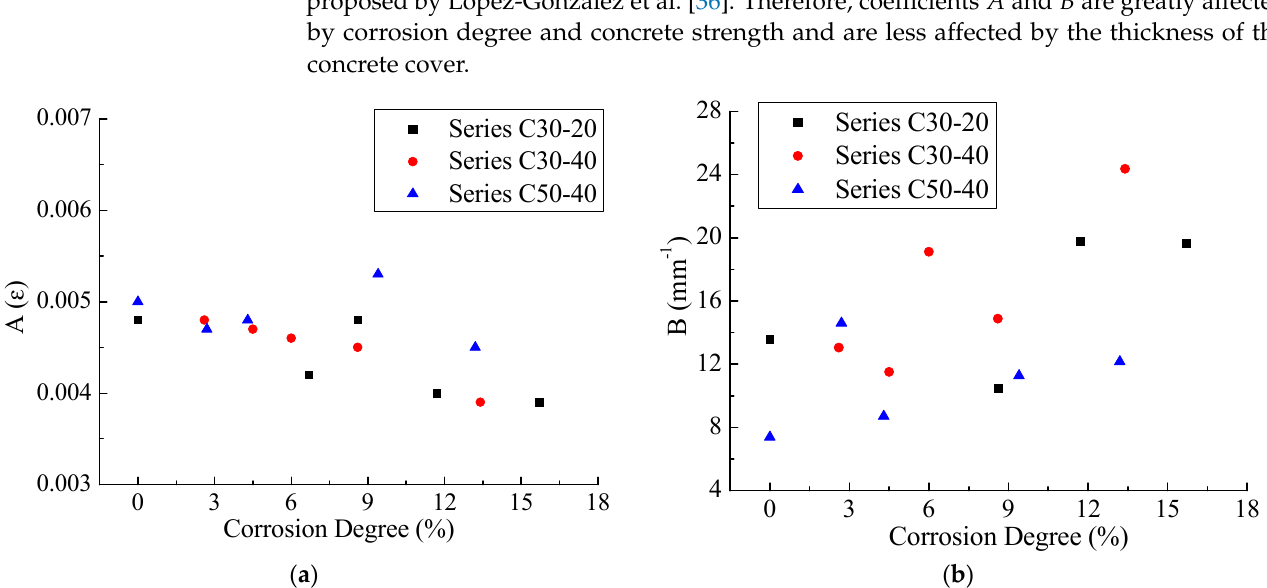
Figure 8. Effects of concrete compressive strength, concrete cover thickness and corrosion degree on ( a ) coefficient A and ( b ) coefficient B .